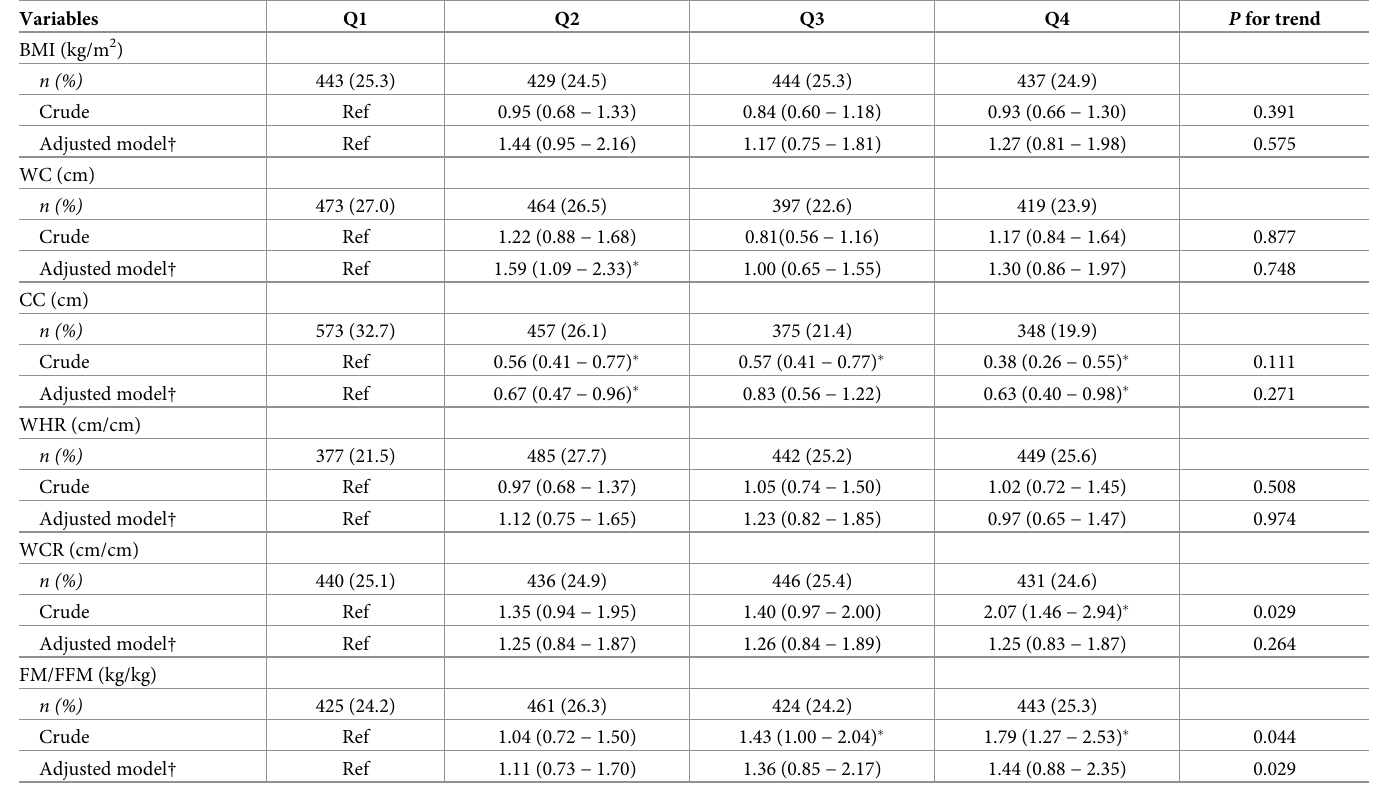
Table 3. Logistic regression analyses of the association of BMI, WC, CC, WHR, WCR and FM/FFM quartiles with cognitive impairment.